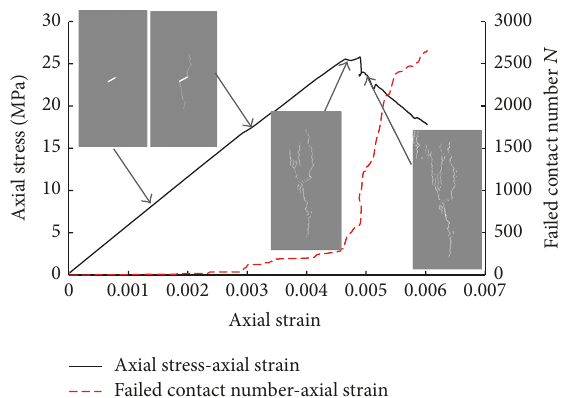
Figure 5: The axial stress-axial strain curve for model containing a single flaw ( 𝛽 = 30 ∘ and 𝐿 = 10 mm) under uniaxial compression.